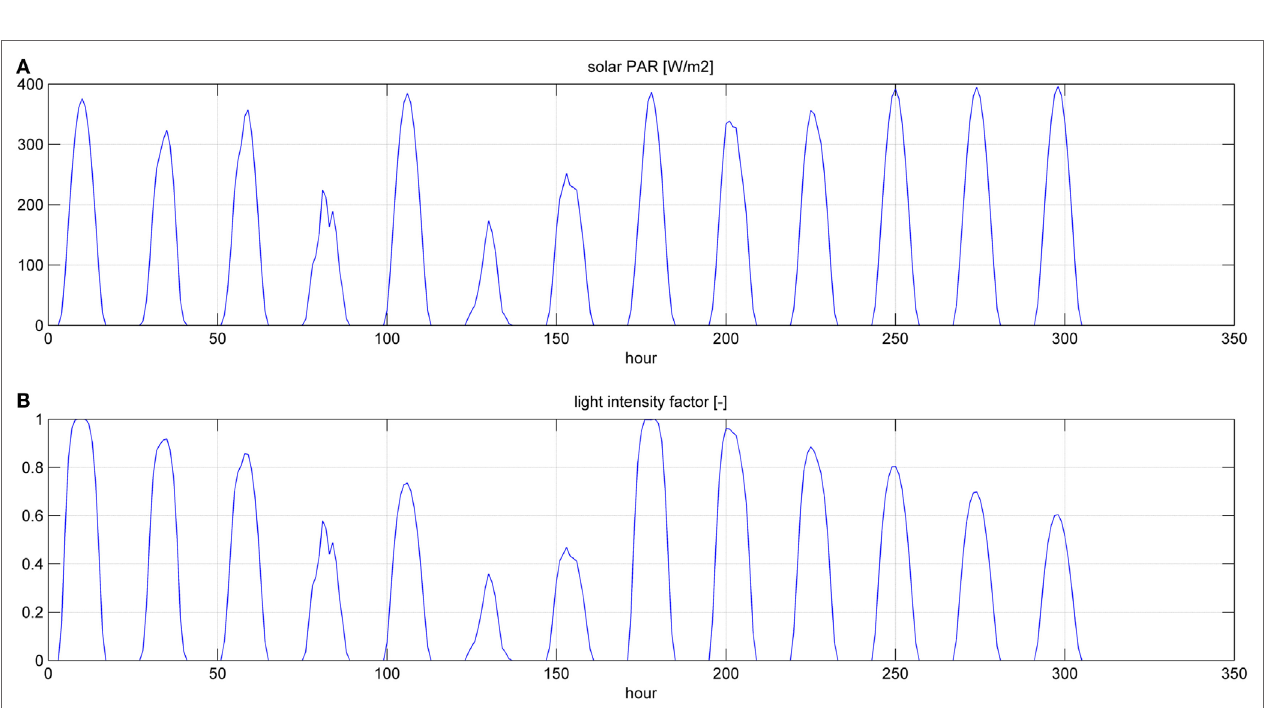
FigUre 6 | Photosynthetic active radiation (Par) (a) and light intensity factor (B) for a simulation time equal to two hrTs